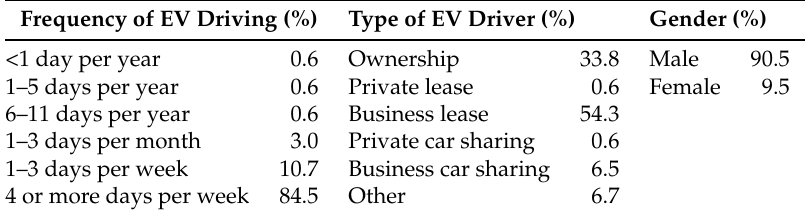
Table 2. Frequencies of EV driving, type of EV driver and gender of the sample ( n = 171).